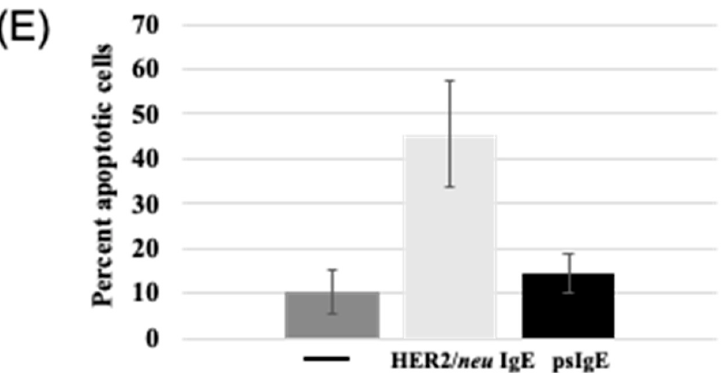
Figure 2. MC binding, penetration and apoptosis of BT-474 cells involve TnT. Note . ( A ) BT-474 cells were grown on confocal slides (50–60% confluent) and MitoTracker™ Green FM was added to the cells. In ( B ) ADMC (1 × 10 5 ) sensitized with HER2/ neu IgE were labeled with CellBrite ® , washed and added to the unlabeled BT-474 cells and visualized for the indicated times by bright-field and fluorescent microscopy. In ( C , D ), co-cultures were incubated for the indicated times, washed, fixed and WGA added as described in the Materials and Methods section. Cells were visualized with fluorescent microscopy. ( E ) Quantification of overall apoptosis comparing psIgE and anti-HER2/ neu IgE-sensitized cells at Day 4 from three experiments. Mean ± sd.